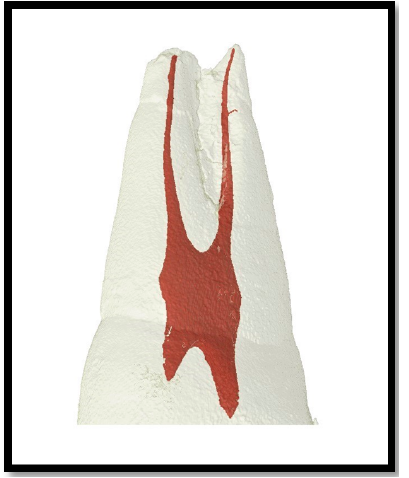
Figure 4. Micro-CT image showing Vertucci’s type IV (2-2) canal configuration.